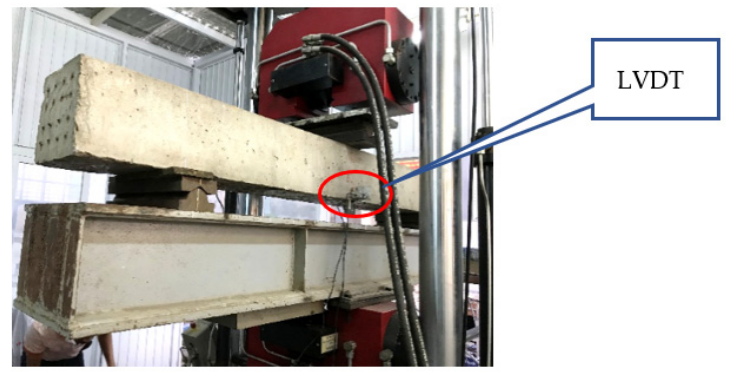
Figure 12. LVDT setup.